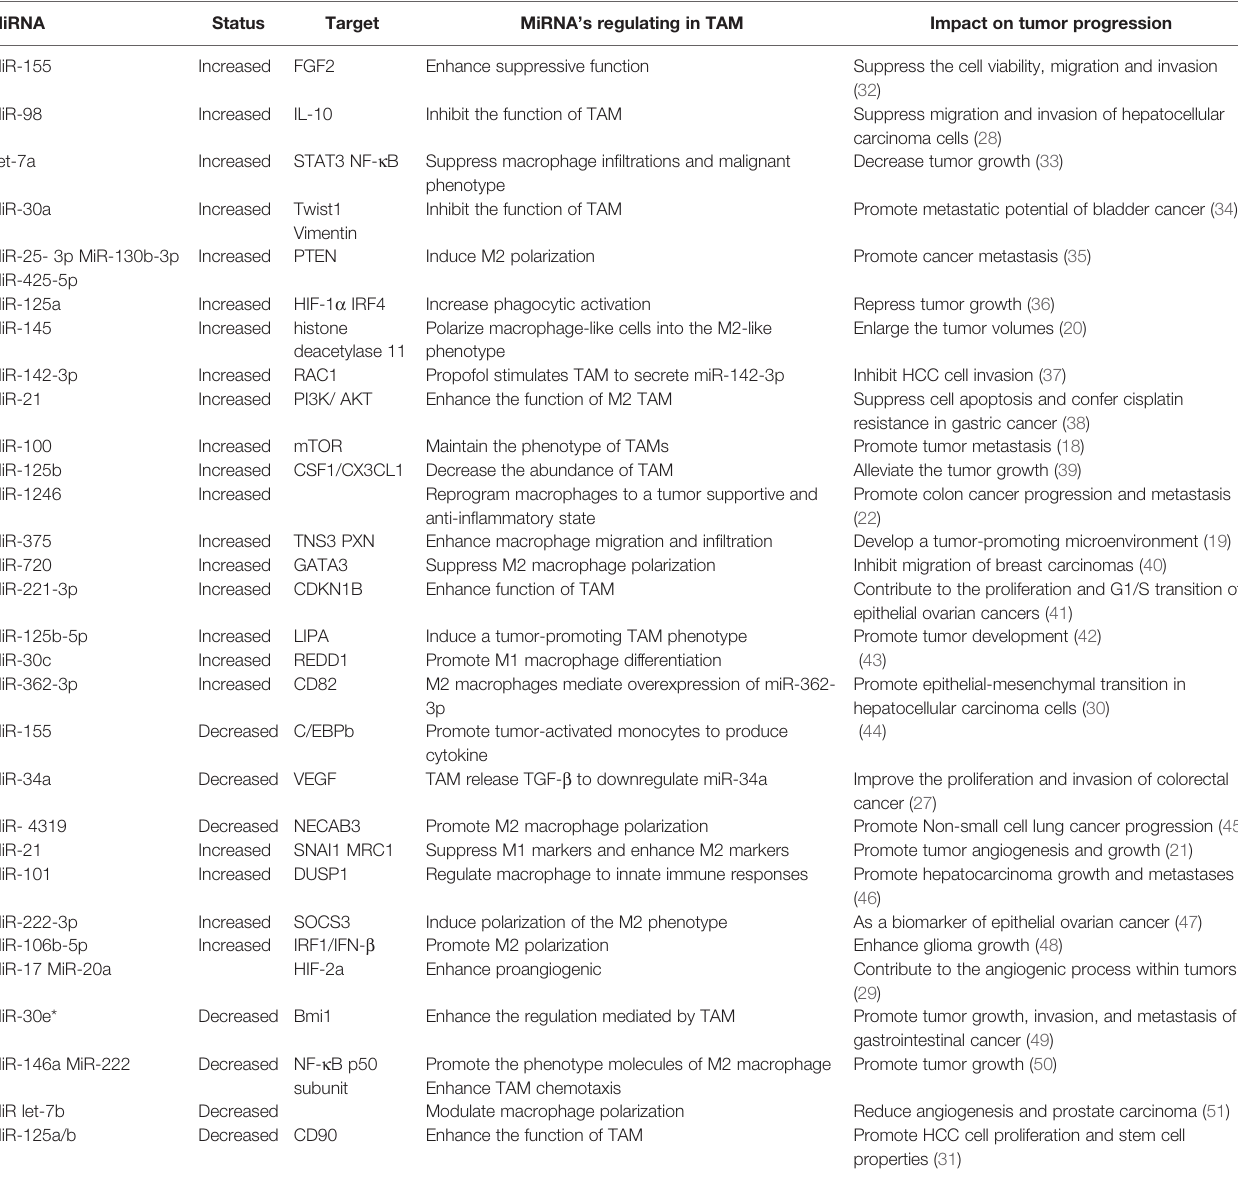
TABLE 1 | MiRNA related with MDSC in tumor